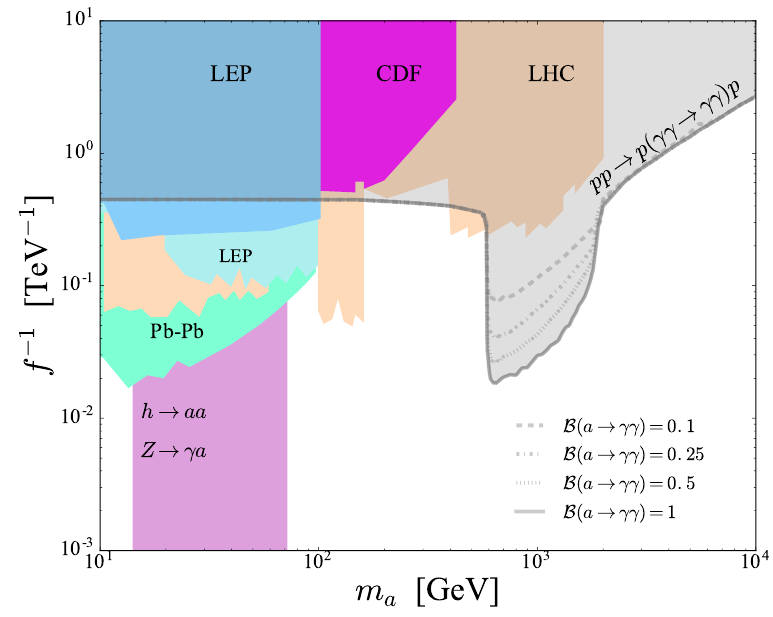
Figure 7 . Exclusion regions on the ALP-photon coupling f (cid:0) 1 and mass m a plane. On light- shaded grey, we have the expected 95%CL exclusion limit for 300 fb (cid:0) 1 in central exclusive diphoton production events for di(cid:11)erent branching ratios of the ALP into two photons. Current excluded regions for B ( a ! (cid:13)(cid:13) ) = 1 are in solid color, are extracted from ref. [13], and can depend on additional assumptions (see text for